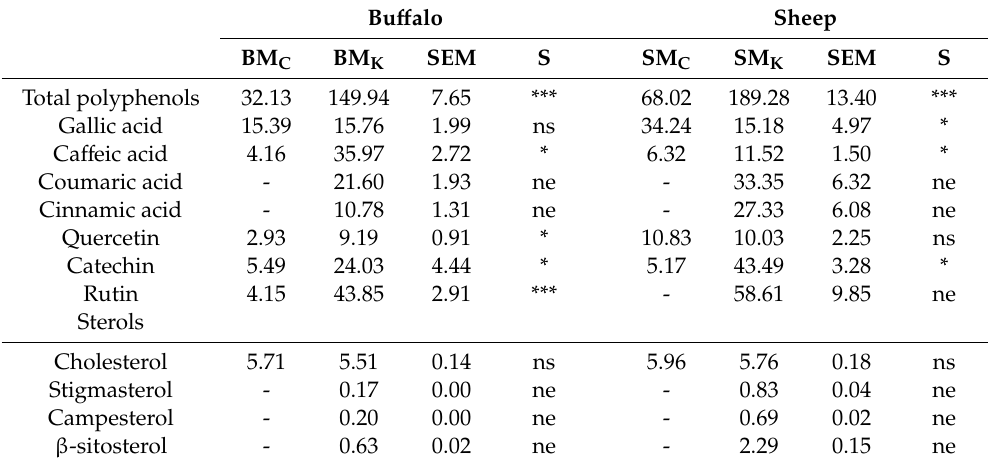
Figure 1. Total polyphenol content of cheese and whey produced with kiwifruit extract and calf rennet. ( a ) Buffalo milk; ( b ) sheep milk. *** P < 0.001 Cheeses obtained with the kiwi extract showed a significantly higher content of polyphenols, both in buffalo (+466%) and sheep cheeses (+278%) (Table 3). Table 3. Polyphenol and sterol content of cheeses made with kiwi extract or calf rennet (mg/100 g of cheese).